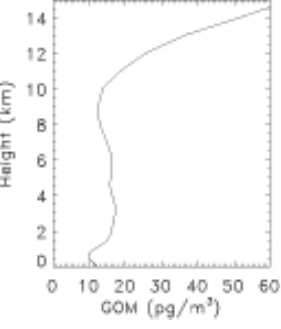
Fig. 4. Initial GOM profile for the southern sites derived from GEOS-Chem simulations. The profiles for HgP is same as the GOM